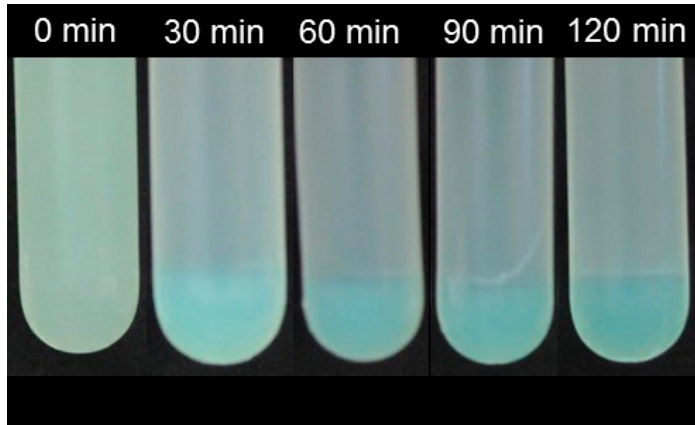
Figure 4. Influence of centrifugation time on the segregation behavior of a mixed protein–polysaccharide system (10 mM phosphate buffer, pH 7): 3.0% caseinate and 1.5% alginate (note: protein phase shown was dyed with methylene blue).